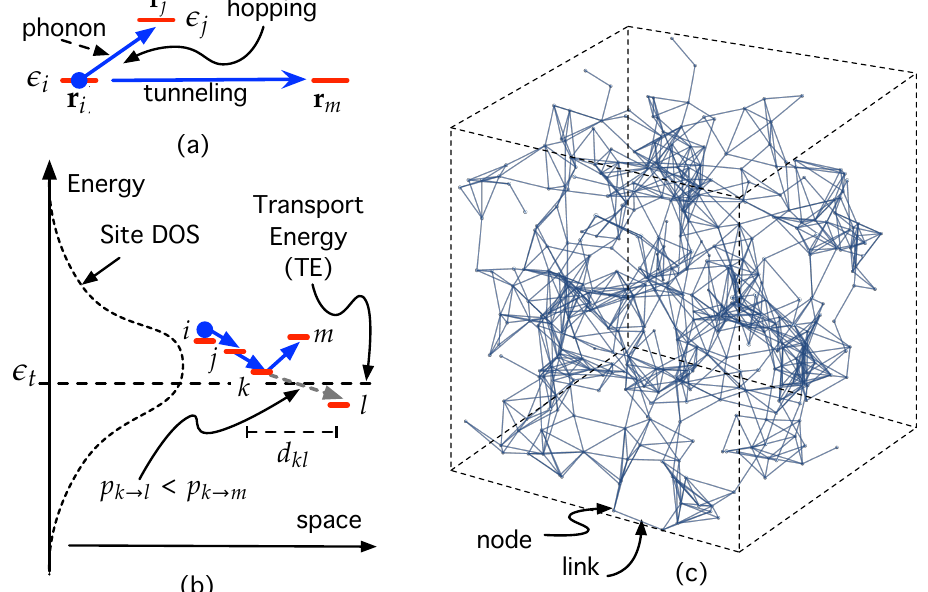
Figure 1. ( a ) Illustration of VRH concept. ( b ) Qualitative representation of how carriers hop between states whose DOS is Gaussian. ε t stands for the transport energy. See the main text for details. ( c ) Network representing a three-dimensional ODS sample. Each node encodes a localized state (site), while each link represents a possible carrier hopping between sites. Thus, not only does the site spatial distribution in R 3 play a key role but so does the energy spectrum in the density of states (DOS). Although there has been some controversy about the DOS in ODSs (either exponential or Gaussian), it has been recently shown that the DOS in ODSs is Gaussian [17]. The reason why an exponential DOS is sometimes used is because it helps simplify the study of hopping transport, leading to an exact solution [17,41]. In the present work, we also use a Gaussian DOS within the framework stated by the Gaussian disorder model (GDM) [17,21] to achieve a sufficiently realistic